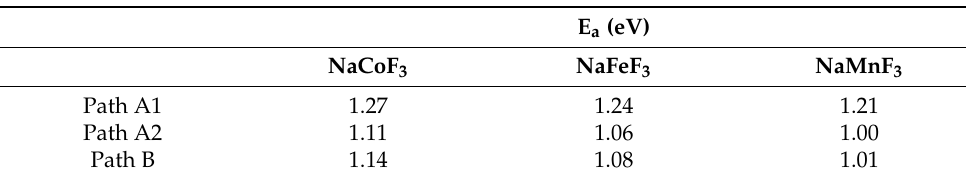
Figure 8. Schematic representation of the Na-ion migration paths for NaMnF 3 : ( a ) path A1 in green and path A2 in blue; ( b ) path B in orange. Legend: Na is indicated in yellow; Mn is indicated in purple; F is indicated in grey.